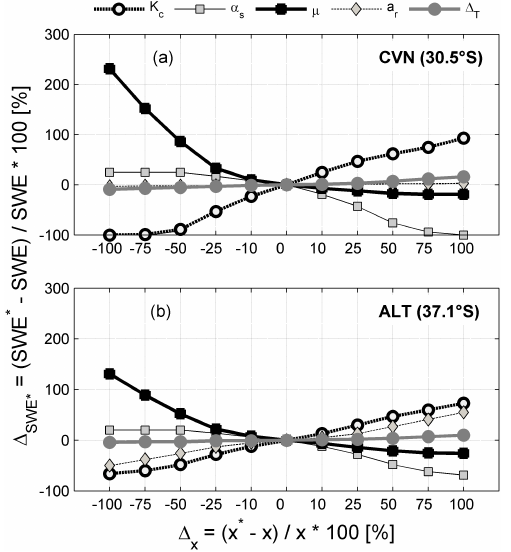
Figure 11. Sensitivity of peak SWE estimates to model forcings and parameters. Average over the 2001–2014 period at selected snow- pillow sites. (cid:49) x represents the percentage change over each param- eter studied with respect to the base case.